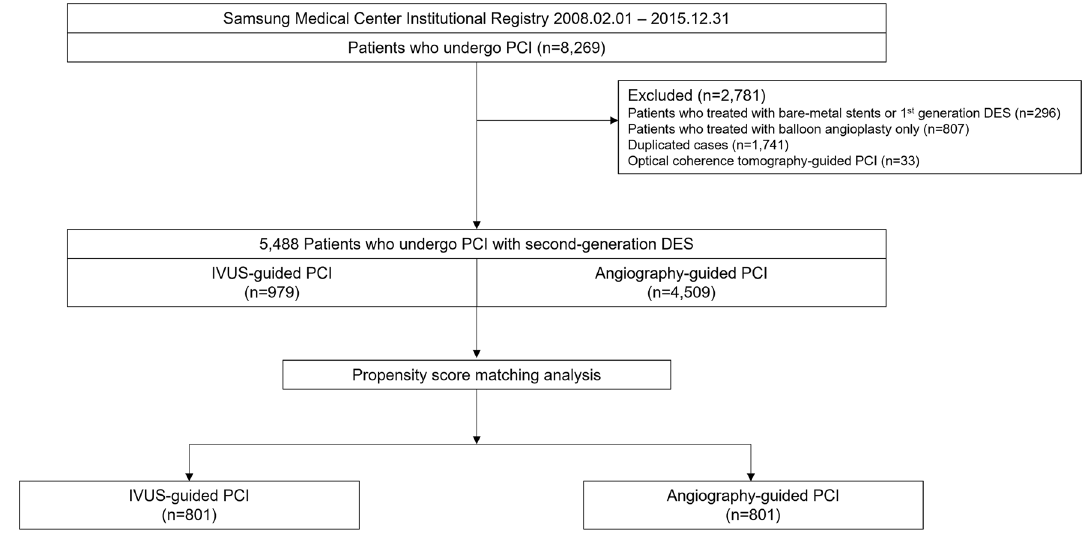
Figure 1. Study flow. A flow diagram is shown. DES, drug-eluting stent; IVUS, intravascular ultrasound; PCI, percutaneous coronary